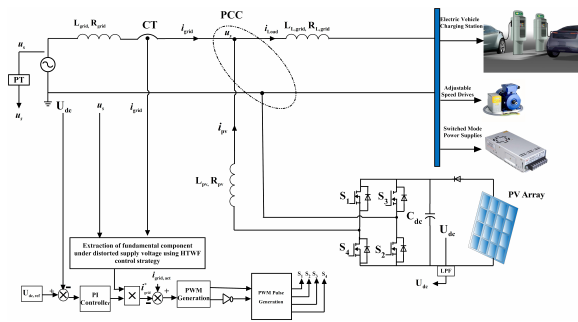
Fig. 1. Block diagram of single-phase grid-tied PV